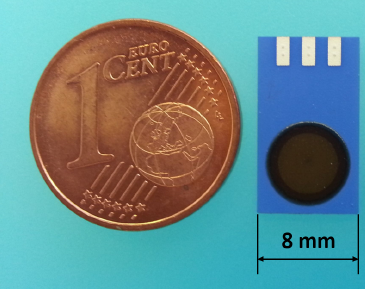
Figure 8. Separated LTCC-based pH